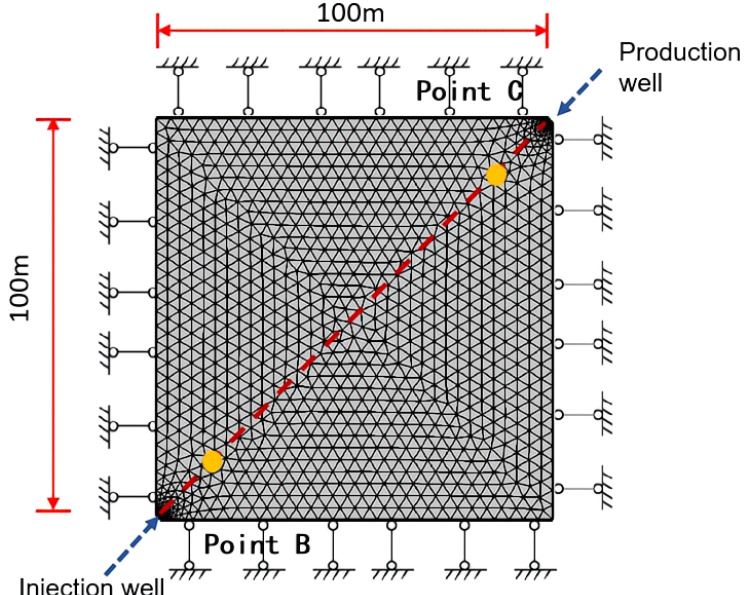
Figure 6. Numerical simulation model for CO 2 - ECBM